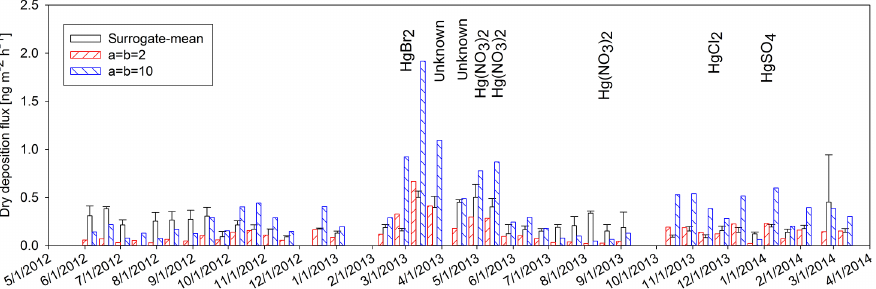
Figure 3. Measured and modeled GOM dry-deposition fluxes. Tekran ® data (correction factor of 3) were used with multiple resistance models ( α = β = 2 and 10). Tentative GOM compounds were determined using the results from nylon membrane